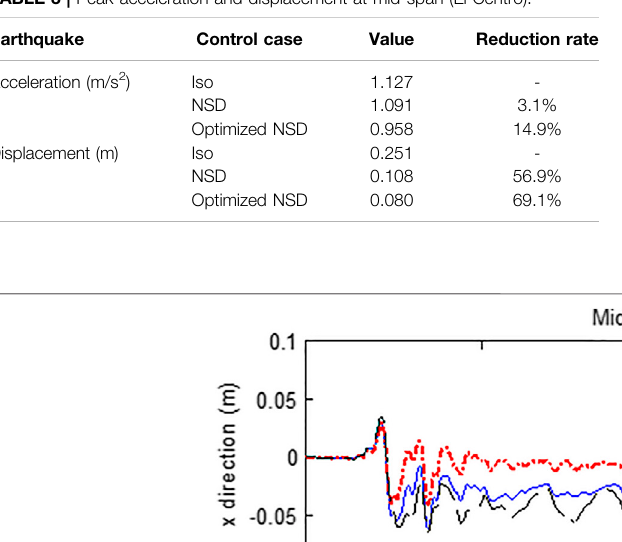
TABLE 3 | Peak acceleration and displacement at mid-span (El Centro).